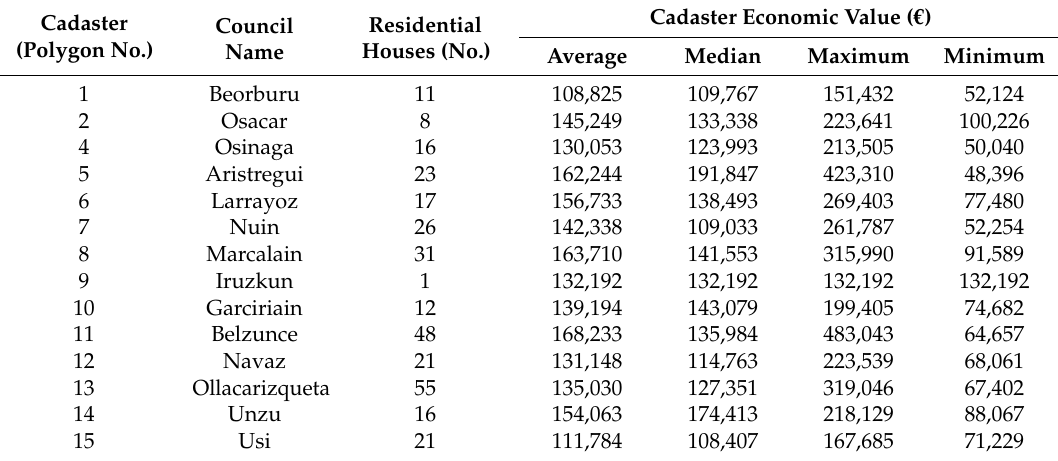
Table 5. Summary table of the cadaster economic value (V) for the residential houses in the Juslapeña Valley. Council polygon cadaster codes No. 3 and No. 16 do not have residential houses (Figure 1A). The cadaster value was estimated for the year 2015, considering the model published in the Foral Decree 334/2001 of November 26